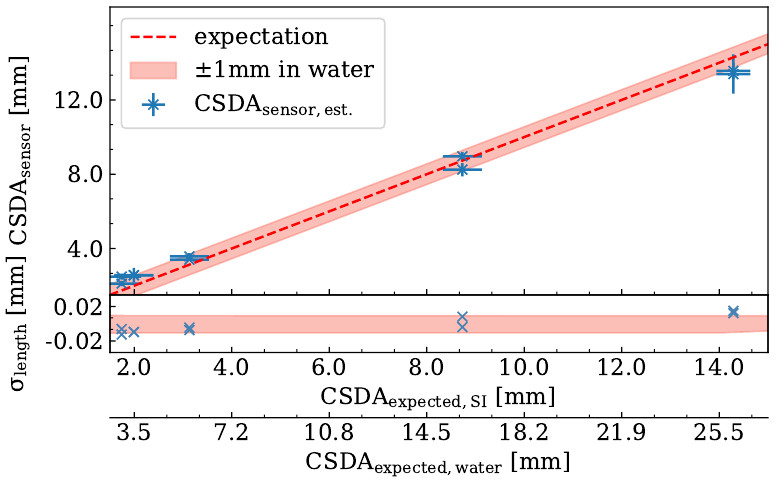
Figure 15. Comparison of CSDA expected, SI for different initial beam energies and the corresponding measured CSDA range CSDA sensor, est estimated by using the longest measured cluster length. The red dotted line indicates the expectation and the light red colored interval the deviation ± 1mm of CSDA expected, water . The accuracy of the estimator is illustrated using the parameter σ length